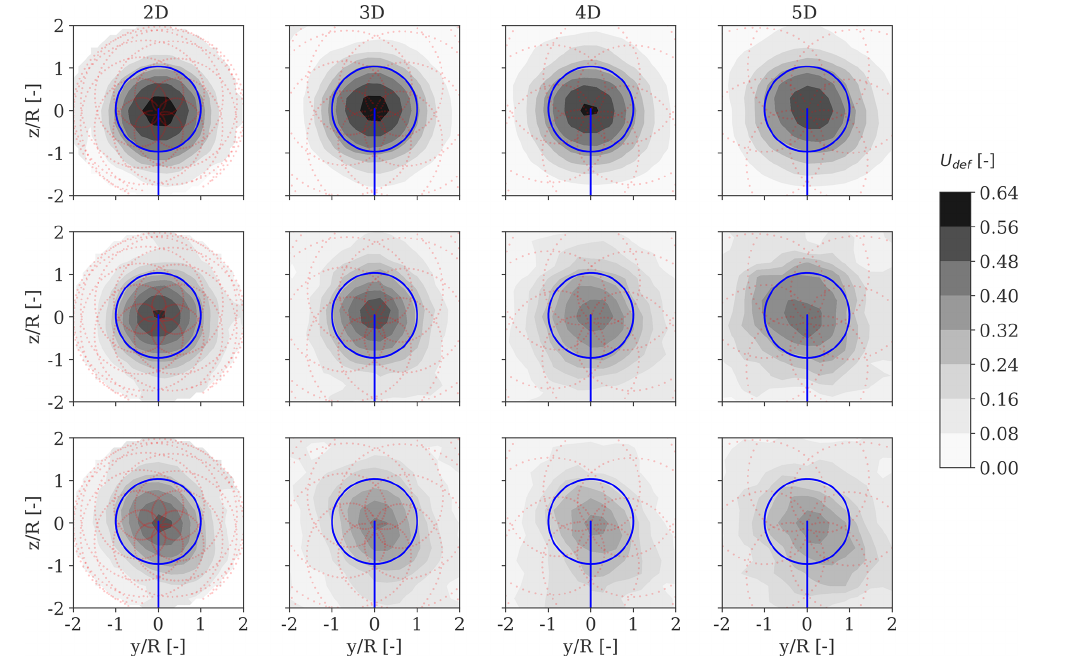
Figure 4. Ensemble-average velocity deficit profiles in the MFoR measured at 2, 3, 4, and 5 D behind the rotor for an inflow wind speed of 7m/s under stable (upper row), near-neutral (middle-row), and unstable (lower row) conditions. The number of scans used to derive the ensemble statistics ranges between 312 and 636, depending on data availability. The SpinnerLidar scanning pattern is shown by red dots, whereas the turbine rotor area is illustrated by solid blue lines. The vertical and lateral coordinates are normalized by the rotor radius and centred at hub